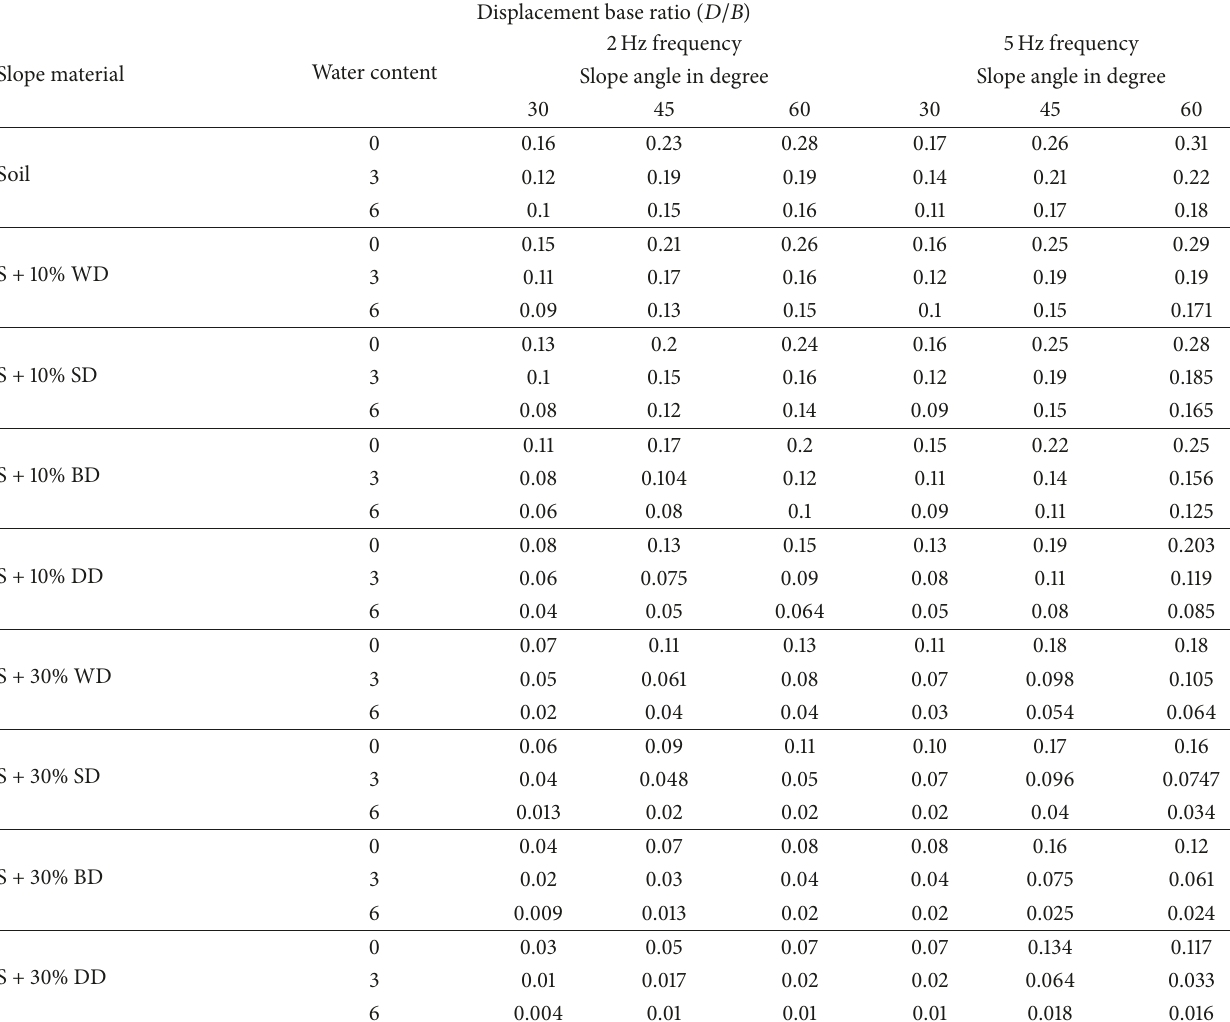
Table 4: Response of slope made up of soil and soil dust mixtures in terms of base displacement at frequency of input motion 2Hz and 5Hz. Displacement base ratio (𝐷/𝐵) Slope